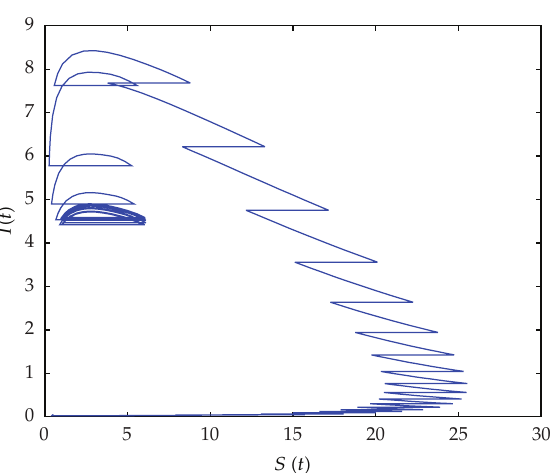
Figure 18: Phase diagram of S (cid:3) t (cid:4) and I (cid:3) t (cid:4) with parameters ρ (cid:7) 5 , μ (cid:7) 0 . 1 , β (cid:7) 1 , α (cid:7) 1 , r (cid:7) 0 . 3 , d (cid:7) 0 . 2 , ω (cid:7) 0 . 2 , T (cid:7) 0 . 8 , and τ (cid:7) 0 . 2.